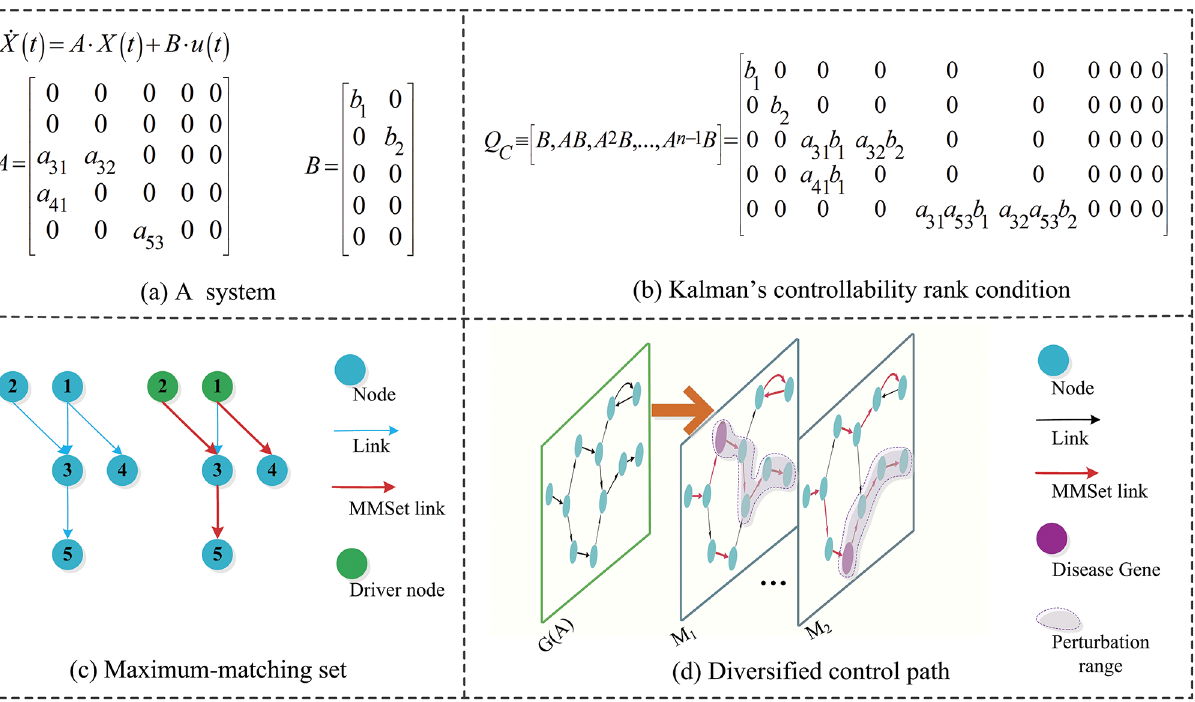
Fig 1. A schematic diagram of diversified control paths. (a): a linear dynamic system with adjacency matrix A and input matrix B . (b): the Kalman ’ s controllability rank condition, if rank ( Q C ) = n , this system is controllable. (c): for the underlying network, propose a maximum-matching set (MMSet) to assess the structural controllability. Links of the MMSet are highlighted by red. (d): for a network G ( A ), differentiated MMSet M 1 and M 2 , marked by red, construct diversified control path sets. Disease genes are marked by purple and their perturbation ranges are indicated by shadow areas.